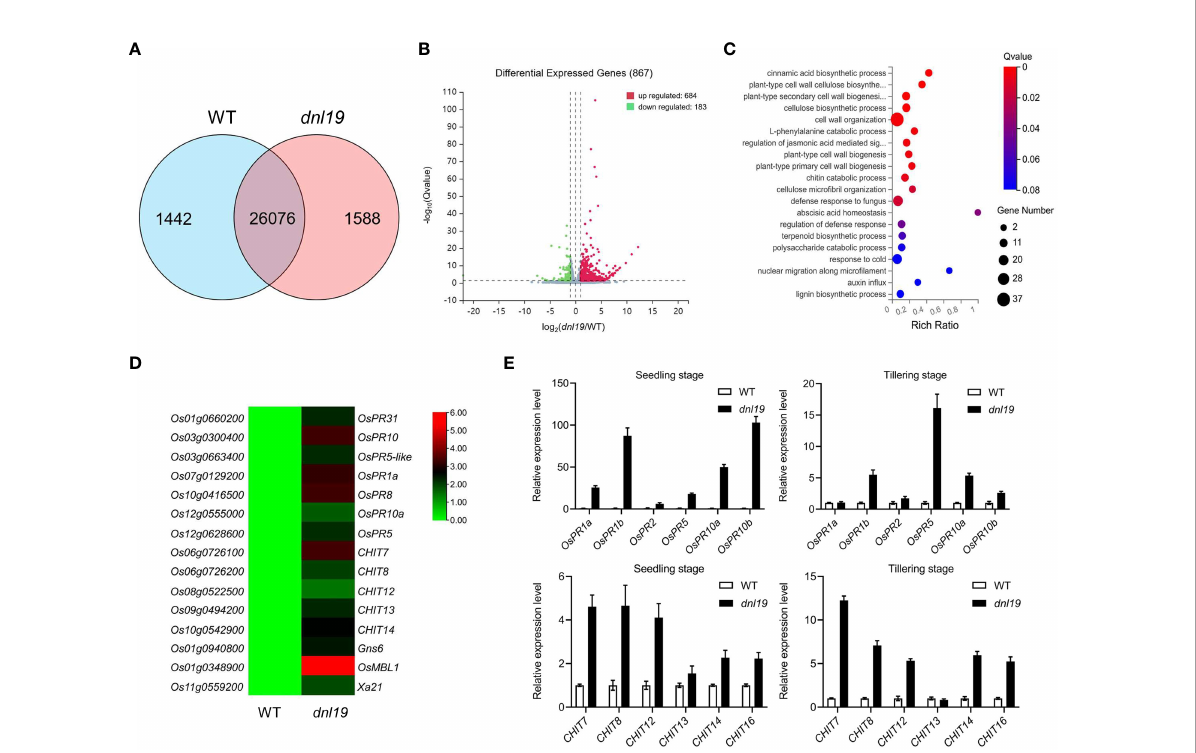
FIGURE 4 Global transcriptome analysis of dnl19 mutant. (A) Venn diagram of common genes in dnl19 and WT. (B) Volcano map of differentially expressed genes (DEGs) between dnl19 and WT. (C) Signi fi cantly enriched GO terms of DEGs between dnl19 and WT. GO terms belong to biological processes. (D) Heatmap of pathogen-associated genes transcription in dnl19 and WT. (E) Investigation of the relative expression of pathogen- associated genes by qRT-PCR. The expression of OsActin1 was used as an internal